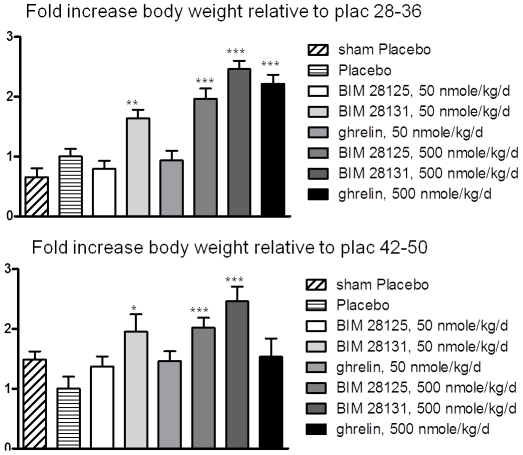
Fold increase of body weight normalised to increase in body weight in the infarct placebo group ( = normal weight gain, i.e. growth) during the first treatment period (day 28–41) and the second treatment period (day 42–56).The first week after pump implantation was chosen for analysis, as the dose/kg becomes lower during treatment due to growth of the animal. Human ghrelin shows tolerance effects, as weight gain during the second period is not significant vs placebo. *: p<0.05, **: p<0.01, ***: p<0.001 compared to placebo.